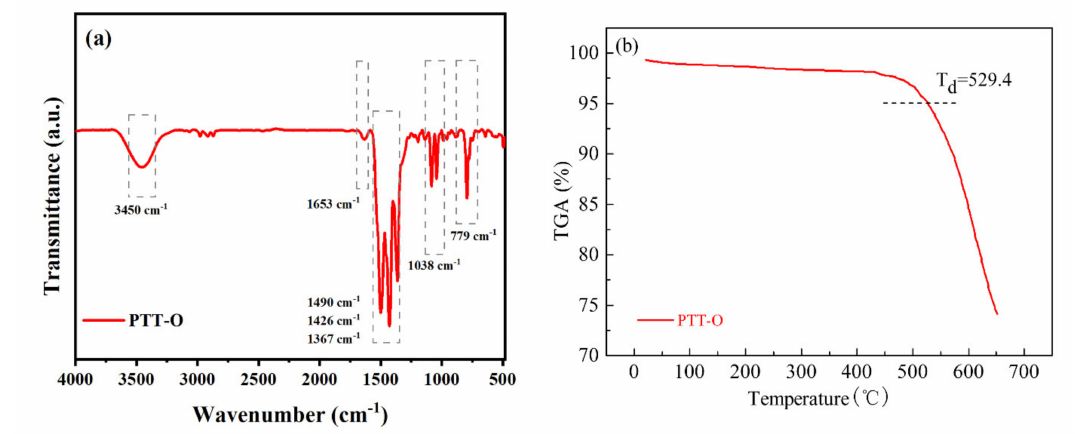
Figure 4. ( a ) The FT-IR spectrum of PTT-O; ( b ) the Thermogravimetric curves of PTT-O. An XPS survey (ESCALAB 250Xi, Thermo Fisher Scientific, Waltham, MA, USA) was conducted to study the elemental compositions and the valence states of PTT-O@C. Figure 5 shows the XPS spectroscopy of C, N and S elements for the composite. The C 1s peaks at 284.6, 285.7 and 286.8 eV belong to the sp 2 C=C in the thiophene (or EDOT) rings, the sp 2 C-N in the triazine group and the sp 2 C-S in the thiophene rings, respectively. The splitting peaks including S 2p 1/2 at 164.24 eV and S 2p 3/2 at around 163.12 eV are the sp 2 S in thiophene rings, and the N 1s peak at 397.8 eV is due to the pyridinic-N from the triazine unit. The peak of O 1s at 532.5 eV is the O-C in EDOT unit [21].